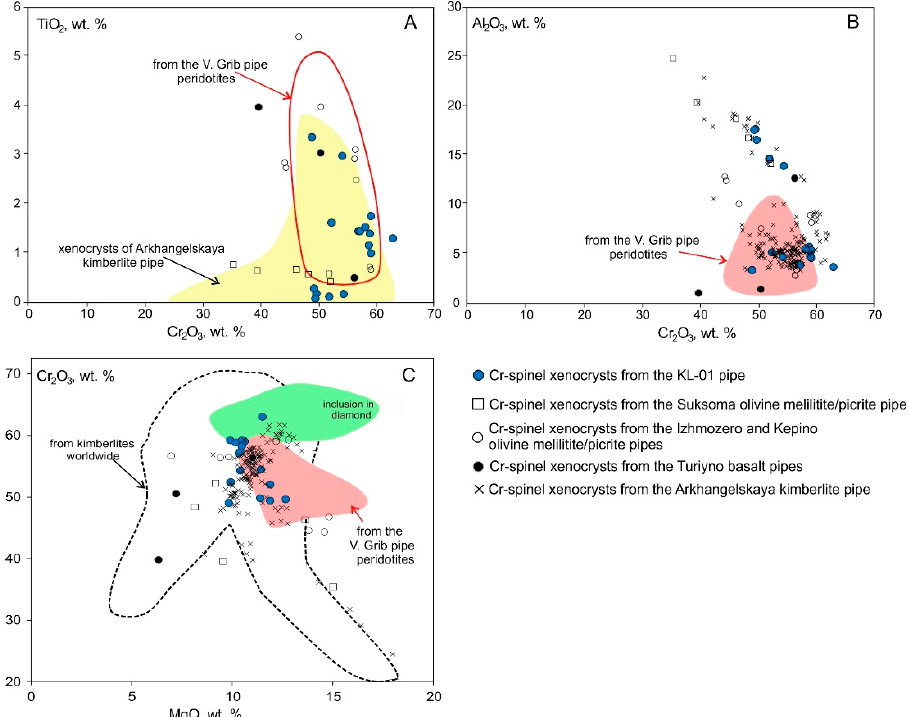
Figure 11. TiO 2 -Cr 2 O 3 ( A ), Al 2 O 3 -Cr 2 O 3 ( B ) and Cr 2 O 3 -MgO ( C ) relation diagrams for Cr-spinel xenocrysts from the KL-01 pipe. Cr-spinel xenocrysts from the Arkhangelskaya pipe [16]; from the Izhmozero and Kepino olivine melilitite/picrite pipes [9]; from the V. Grib pipe peridotites (Table S5-1 in Supplementary Material), Suksoma and Turiyno field pipes [9]. Fields for Cr-spinel from the kimberlites worldwide and diamond inclusions [42].